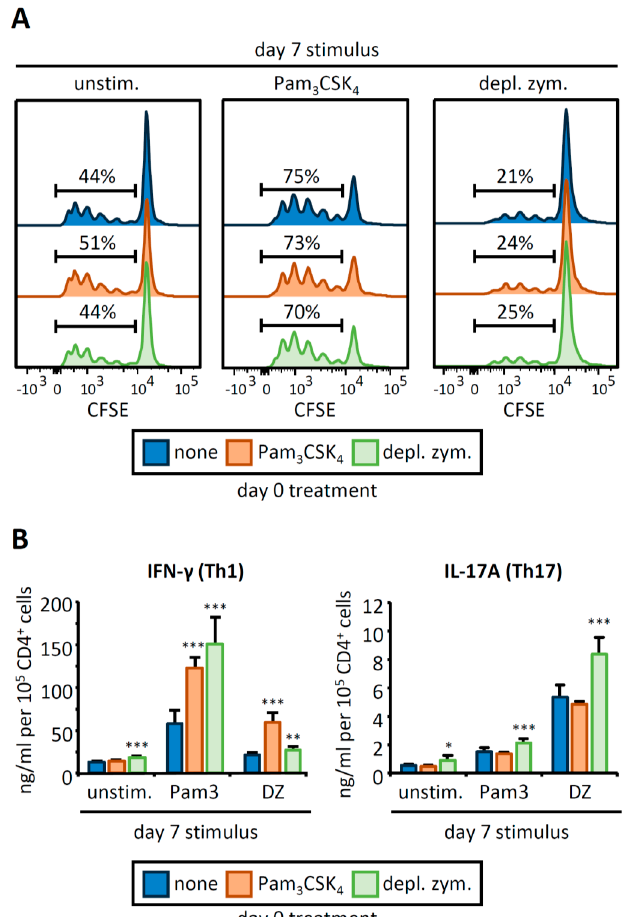
Figure 2. APCs derived from HSPCs stimulated with Pam 3 CSK 4 or depleted zymosan prime enhanced Th1 and Th17 responses in OVA-specific CD4 T cell cocultures. APCs obtained as shown in Figure 1 were loaded with the OVA 323–339 peptide and cocultured with CFSE-labeled CD4 T cells isolated from OT-II mice at 1:5 ratio (APC:T cell). Following three days of coculture, T cells were harvested for ( A ) flow cytometry analysis of proliferating CD4 + T cells and ( B ) cytokine production (IL-17A and IFN- γ ) after 24 h of restimulation with PMA and ionomycin. Cytokine data was normalized by CD4 T cell numbers (shown in Figure A1E) and represent means ± SD of triplicate cultures, * p < 0.05, ** p < 0.01, *** p < 0.001 with respect to day 0 none. Results shown are from one experiment representing three independent experiments.